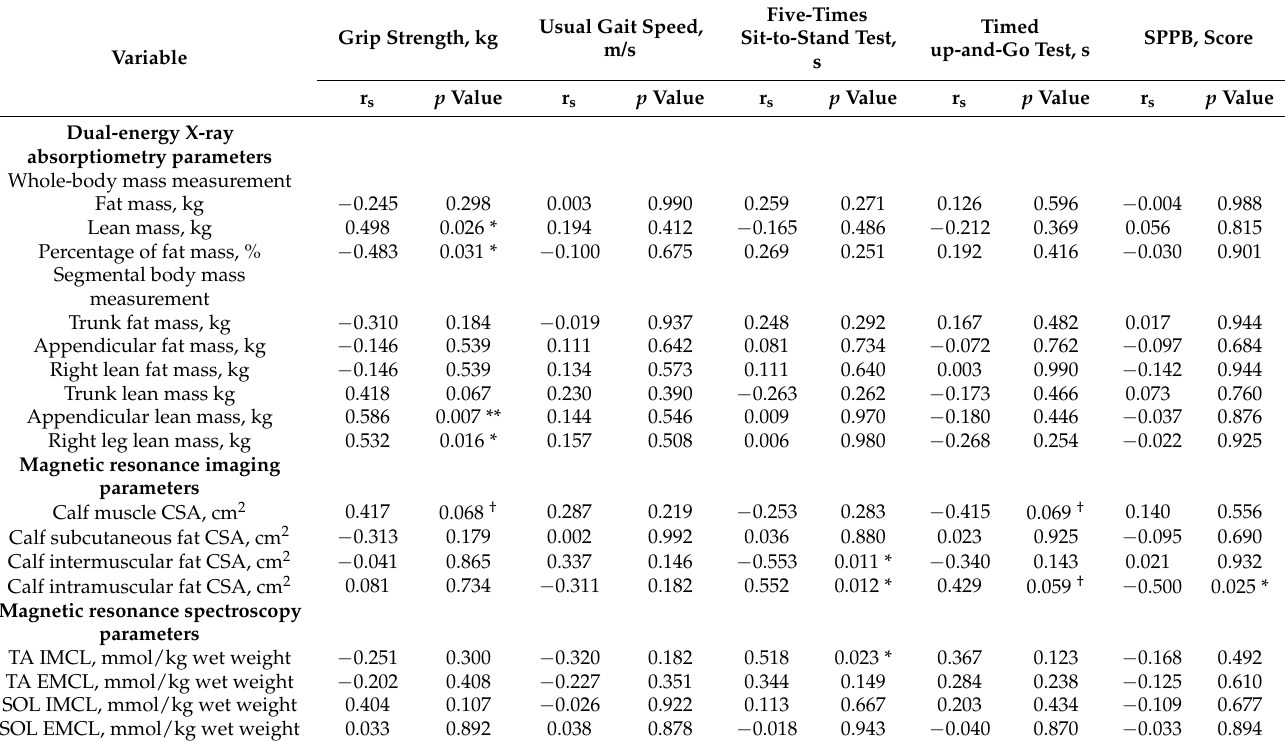
Table 2. Relationship between physical performance and body composition measures in